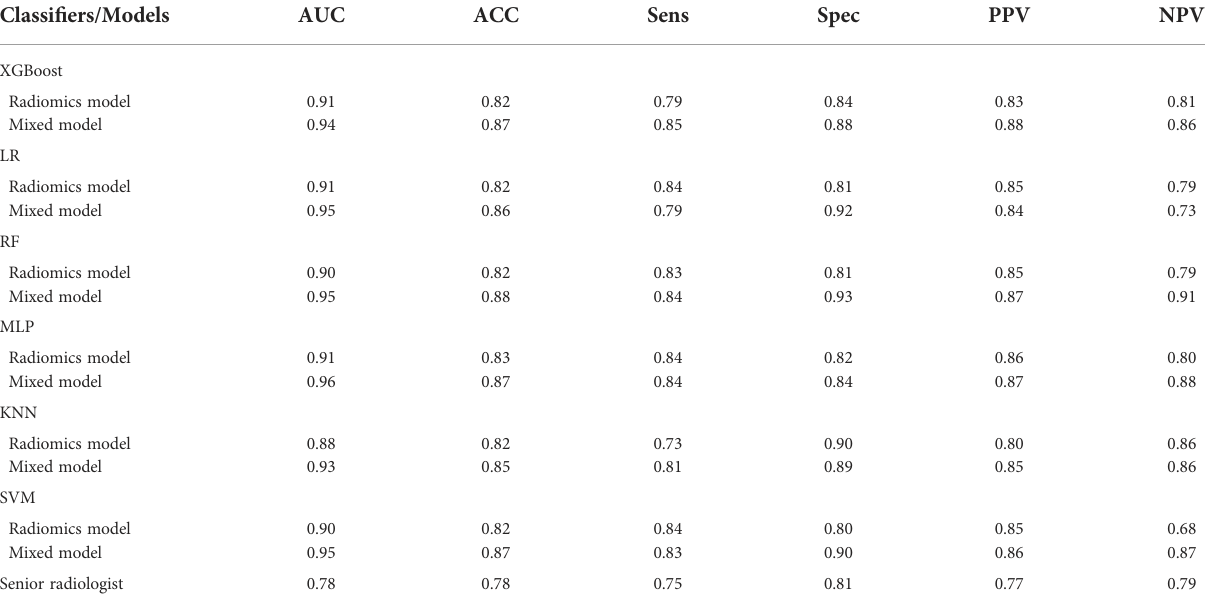
TABLE 5 Diagnostic performances of the classi fi ers for radiomics and mixed model and the senior radiologist in the validation cohort. Classi fi ers/Models AUC ACC Sens Spec PPV NPV XGBoost Radiomics model Mixed